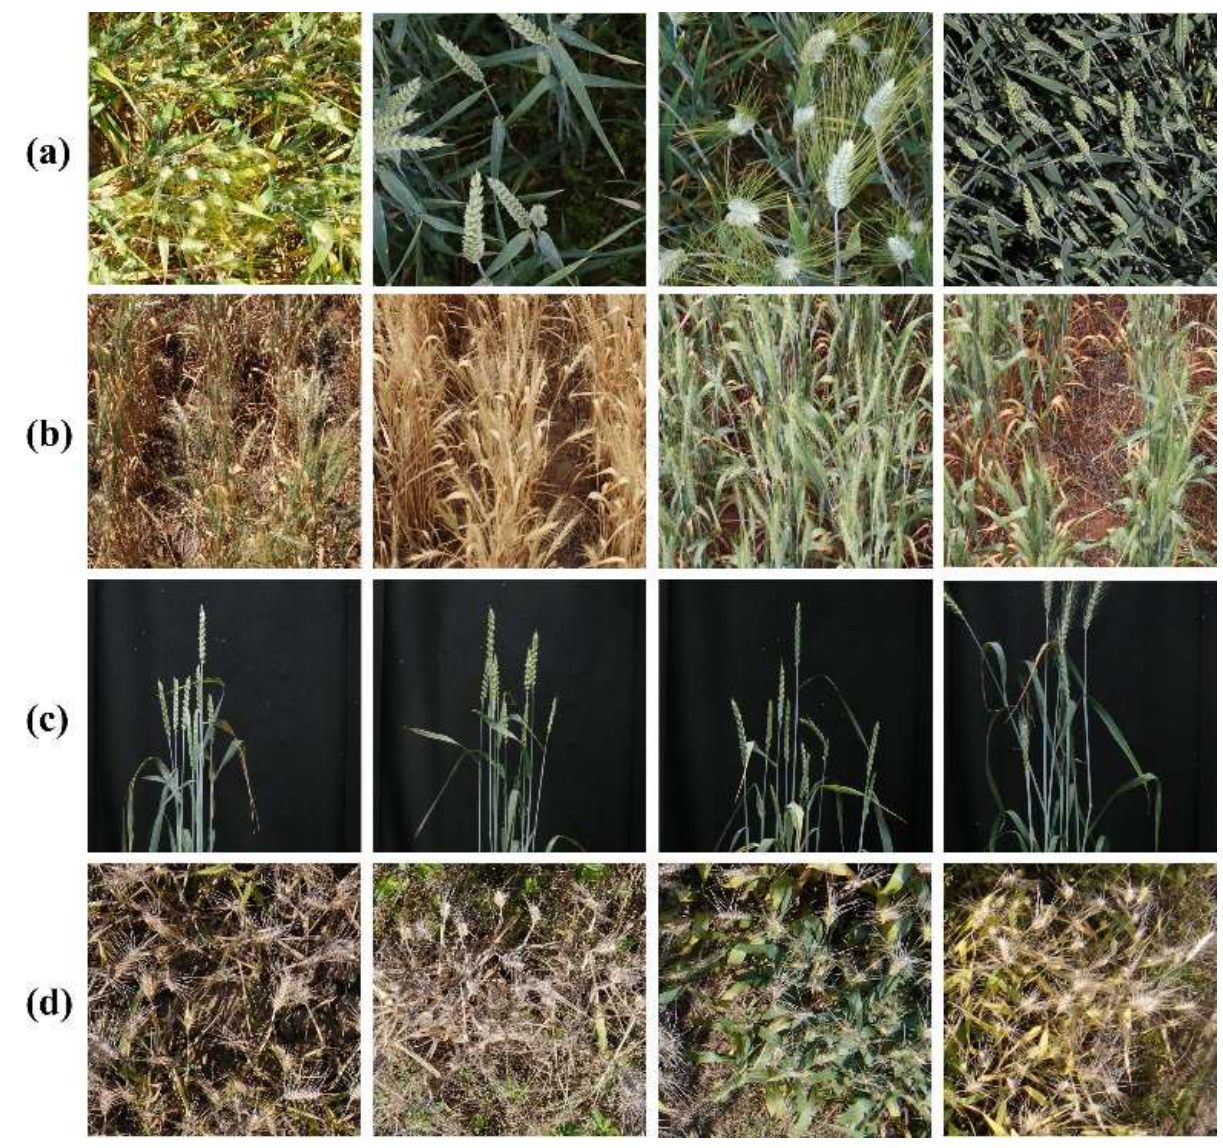
Figure 3. Examples of publicly available wheat head datasets: ( a ) GWHD, ( b ) SPIKE, ( c ) ACID, and ( d ) UWHD.